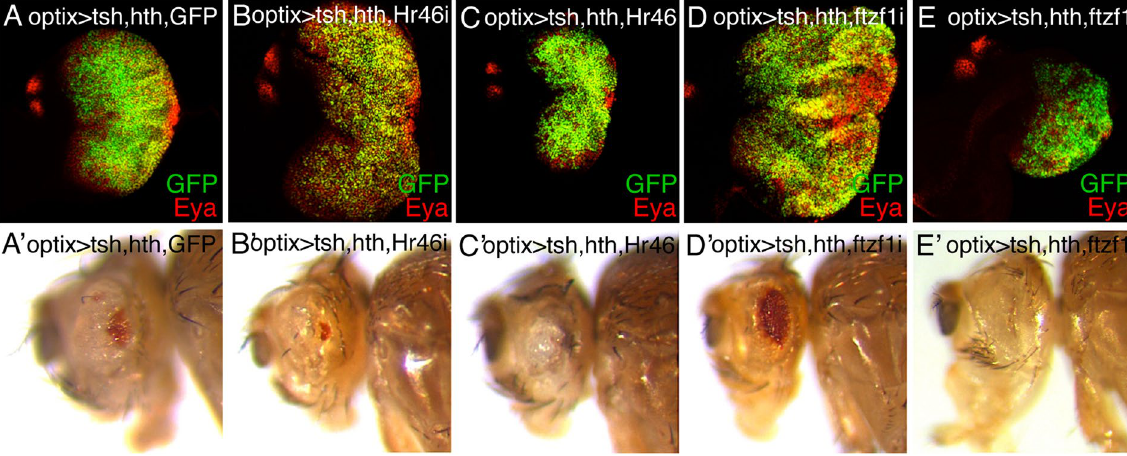
Figure 6. Nuclear receptors Hr46 and ftz - f1 functionally interact with hth + tsh in inducing tissue overgrowth. L3 eye discs, stained for GFP and Eya (upper panel) and lateral views of adult heads (lower panels) of the indicated genotypes (note that all genotypes harbor equal number of UAS-transgenes). RNAi-mediated attenuation ( B ) or overexpression ( C ) of Hr46 enhances or suppresses, respectively, the hth + tsh-induced eye disc overgrowth. In adults, however, while Hr46 attenuation enhances the tissue overgrowth/loss of eye ( B’ ), its overexpression reduces the tissue overgrowth, but without rescuing retina differentiation ( C’ ). RNAi-mediated attenuation of ftz - f1 ( D ) or overexpression ( E ) enhances or suppresses, respectively, the hth + tsh-induced eye disc overgrowth. In this case, ftz - f1 attenuation partly rescues the eye reduction of hth + tsh individuals ( D’ ). Co-overexpression of ftz - f1 suppresses the lateral cuticle overgrowth, without rescuing retina differentiation ( E’